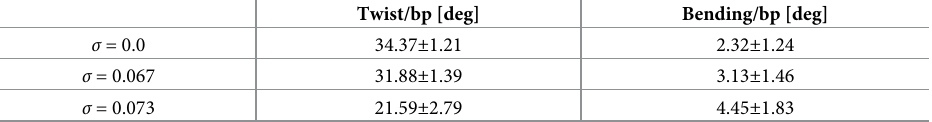
Table 2. Deformation of the TATA-Box under different levels of unwinding, averaged over both sequences. Parameters have been obtained by computation of the rigid-body transformation from the C-G base-pair prior to the TATA-Box to the first C-G base-pair after it. Our procedure is explained in chapter 5 in S1